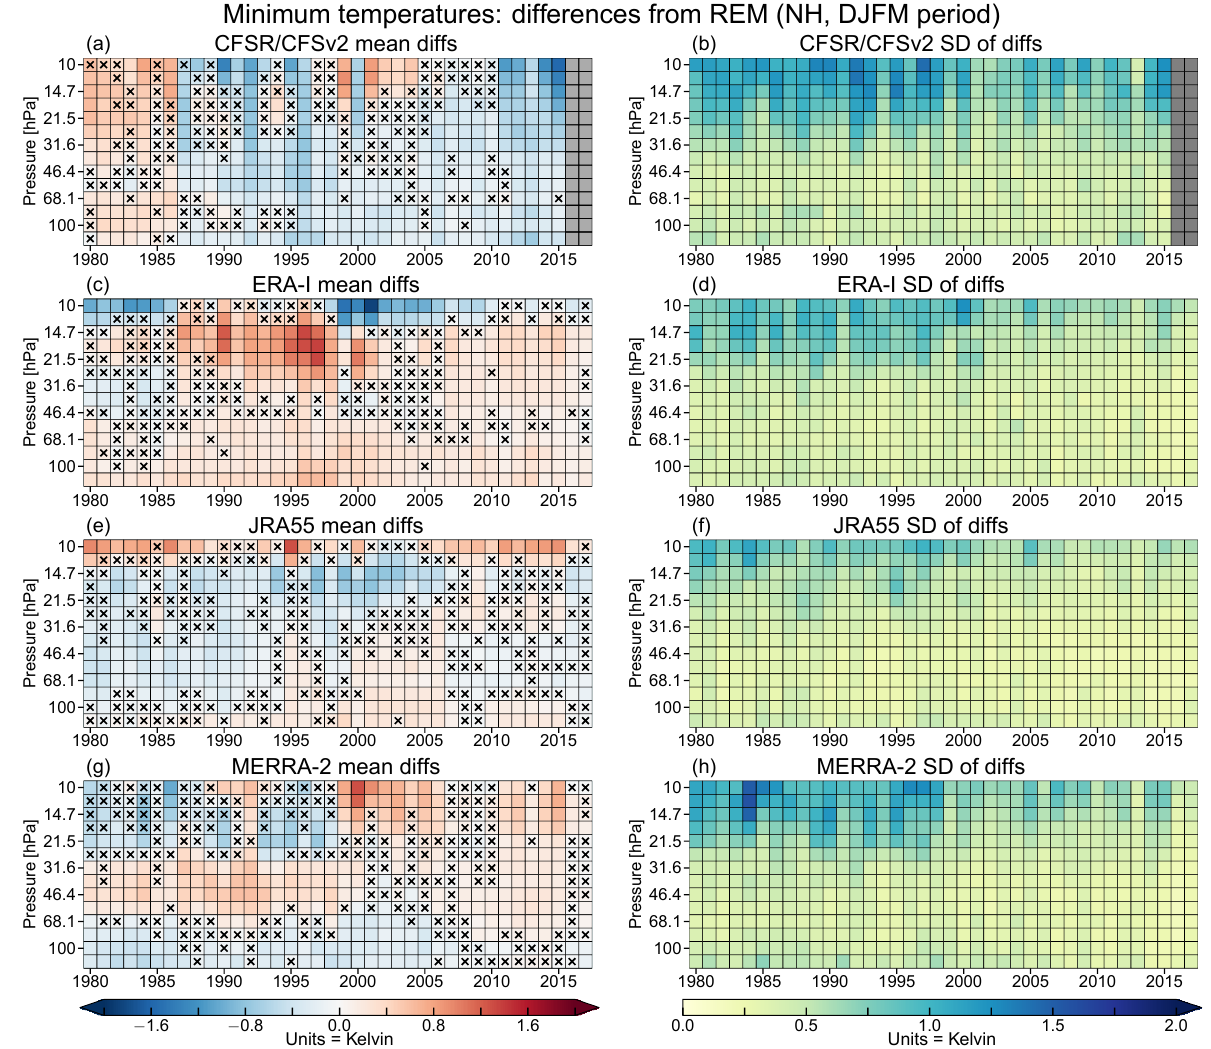
Figure 5. As in Fig. 4 but for the NH winter seasons (DJFM) for 1979/1980 through 2015/2016. Note that different color ranges are used for the NH shown here than in Fig. 4 for the